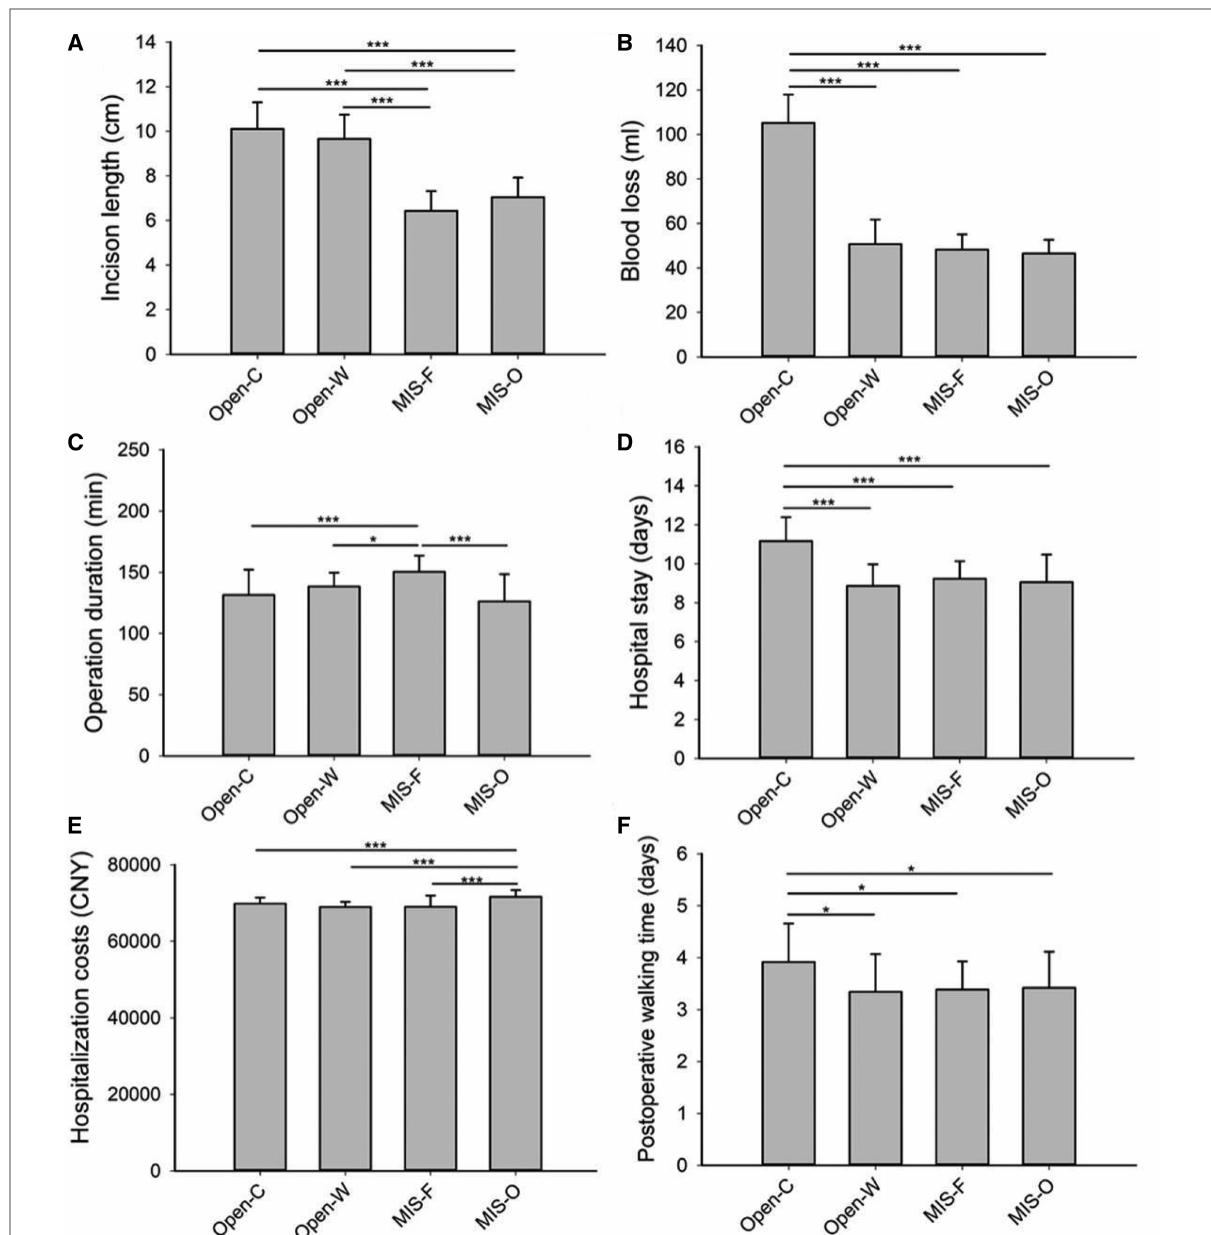
FIGURE 2 Comparison of various clinical parameters among the four groups. Comparison of various clinical parameters including incison length ( A ), blood loss ( B ), operation duration ( C ), hospital stay ( D ), hospitalization costs ( E ) and postoperative walking time ( F ) among the four groups. Open-C, conventional open approach; Open-W, Wiltse approach; MIS-F, percutaneous approach with fl uoroscopy guidance; MIS-O, percutaneous approach with O-arm navigation. * P <0.05; ** P <0.01; *** P